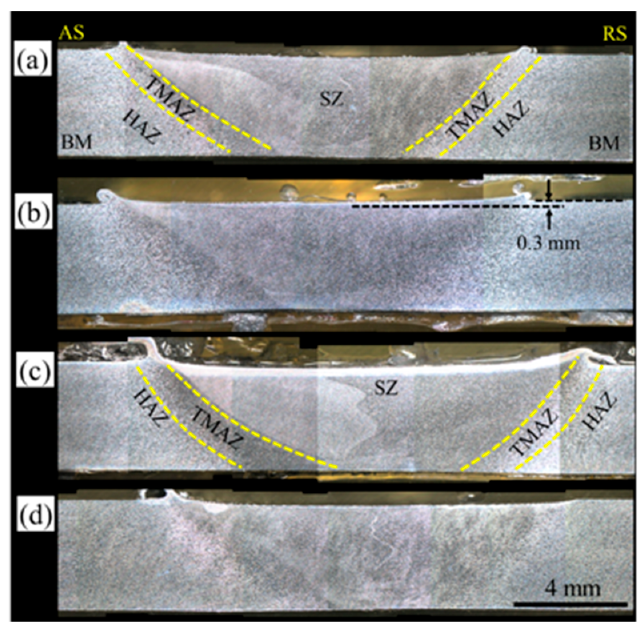
Figure 2. Macro photos of similar joints of Al6061(T6) with different welding parameters: ( a ) Sample A-1, ( b ) Sample B-1, ( c ) Sample D-1, and ( d ) Sample C-4. SZ: stir zone; TMAZ: thermomechanical- affected zone; and HAZ: heat-affected zone.